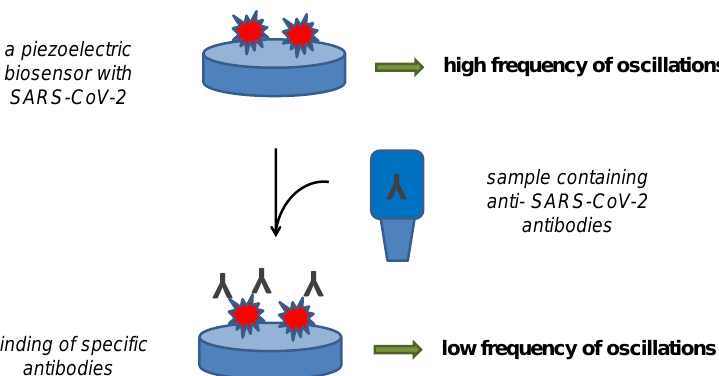
Figure 3. Principle of a piezoelectric biosensor for the detection of anti-SARS-CoV-2 antibodies.